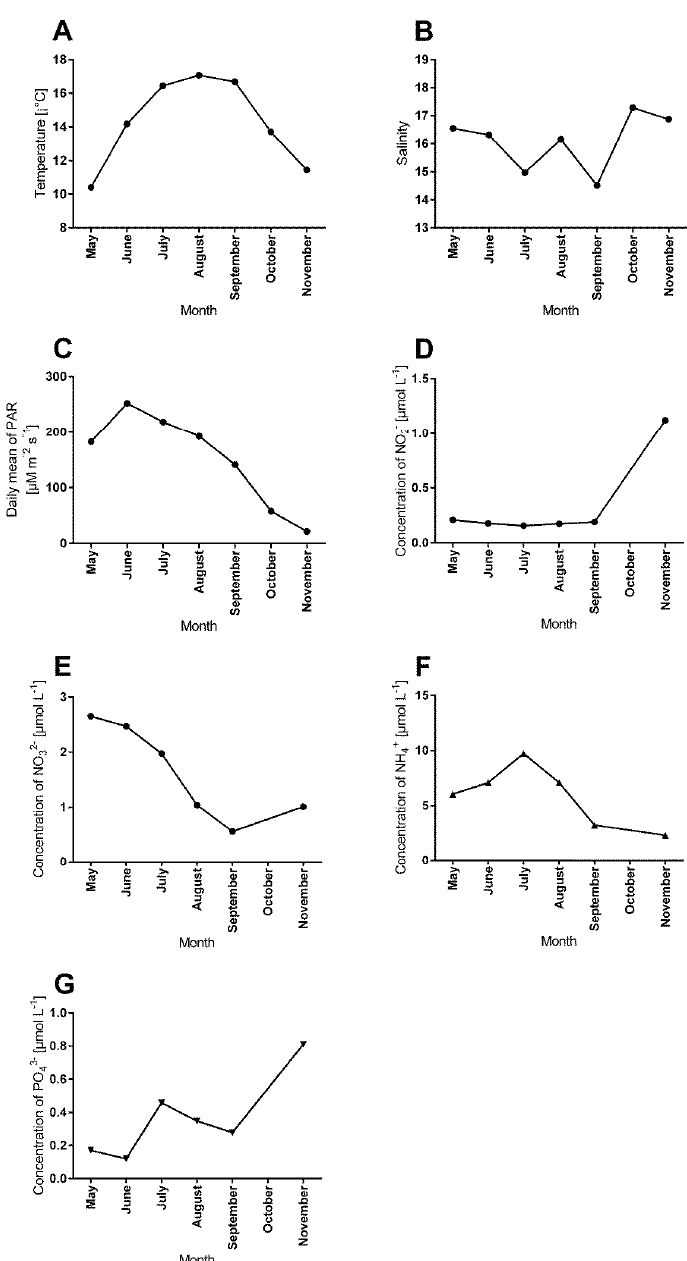
Figure A1. Seasonal change of ( A ) temperature; ( B ) salinity; ( C ) photosynthetically-active radiation (PAR); ( D ) NO 2 − , ( E ) NO 3 2 − , ( F ). PO 4 3 − ; ( G ) NH 4 + in Falckenstein Beach. In ( A – C ) the presented data are means of the week before eelgrass sampling, in ( D – G ) the data are for samples that were collected on the sampling